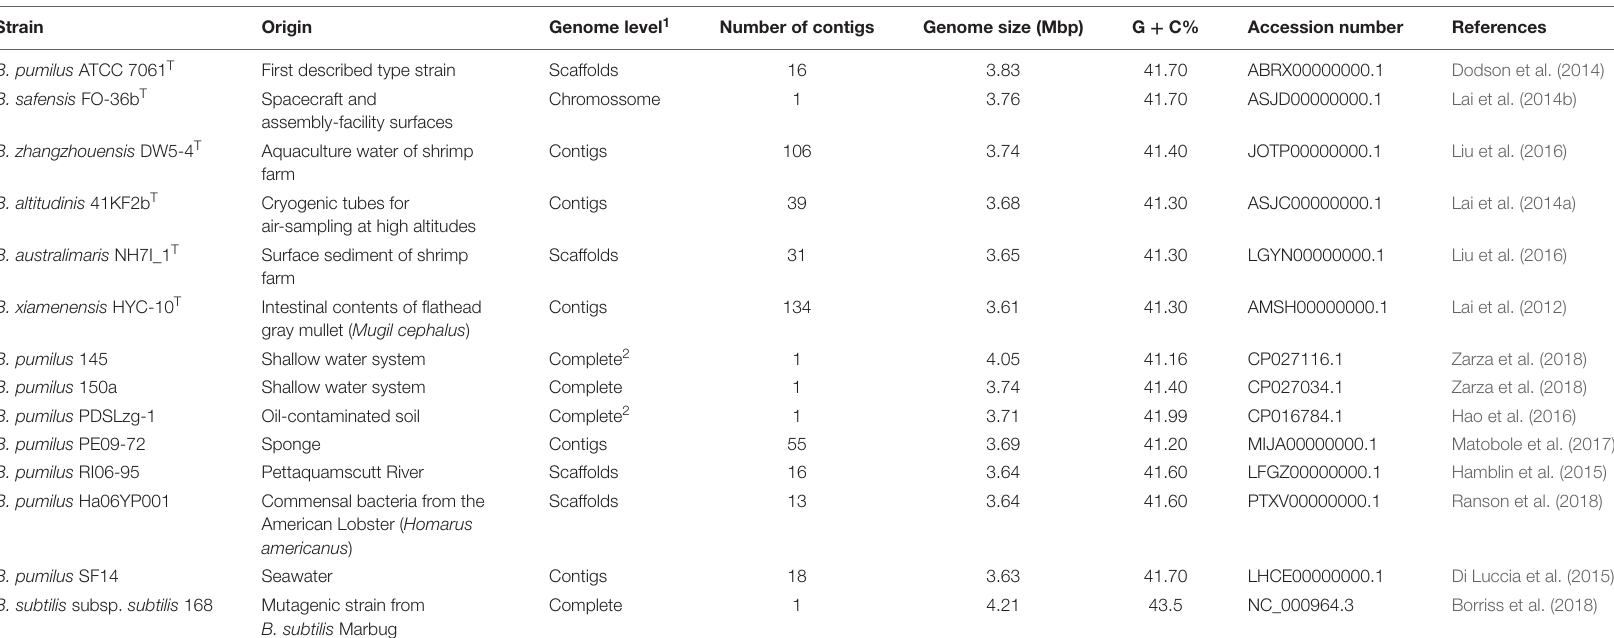
TABLE 1 | List of Bacillus genomes selected for phylogenetic analyses and the overall genome-related index (OGRIs) calculation.